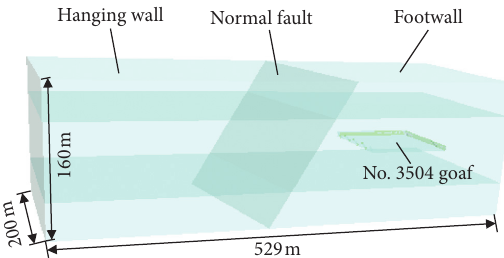
Figure 5: Schematic diagram of numerical model.